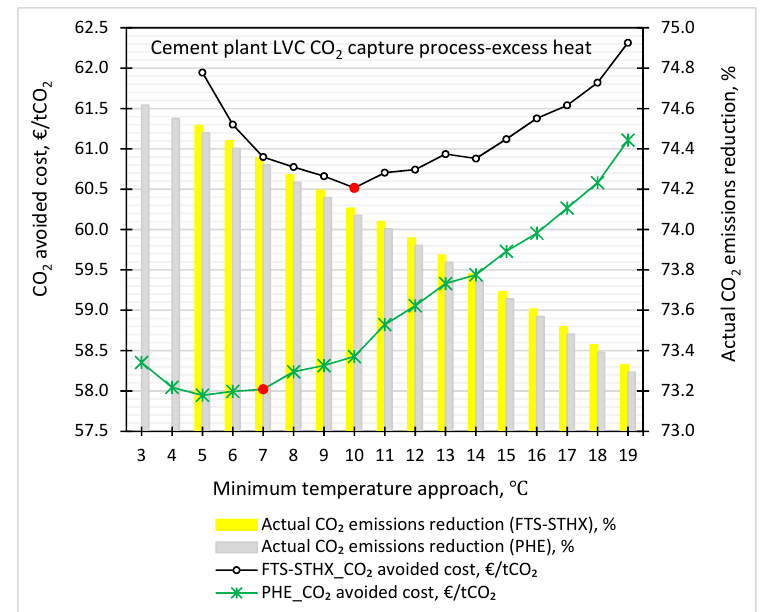
Figure 17. Energy and heat exchanger costs trade-off analyses at different ∆ T min for different heat exchanger types in a standard CO 2 capture from cement flue gas (red dot is the ∆ T min where optimum CO 2 capture cost is achieved which can be different from the CO 2 avoided cost optimum the ∆ T min ).